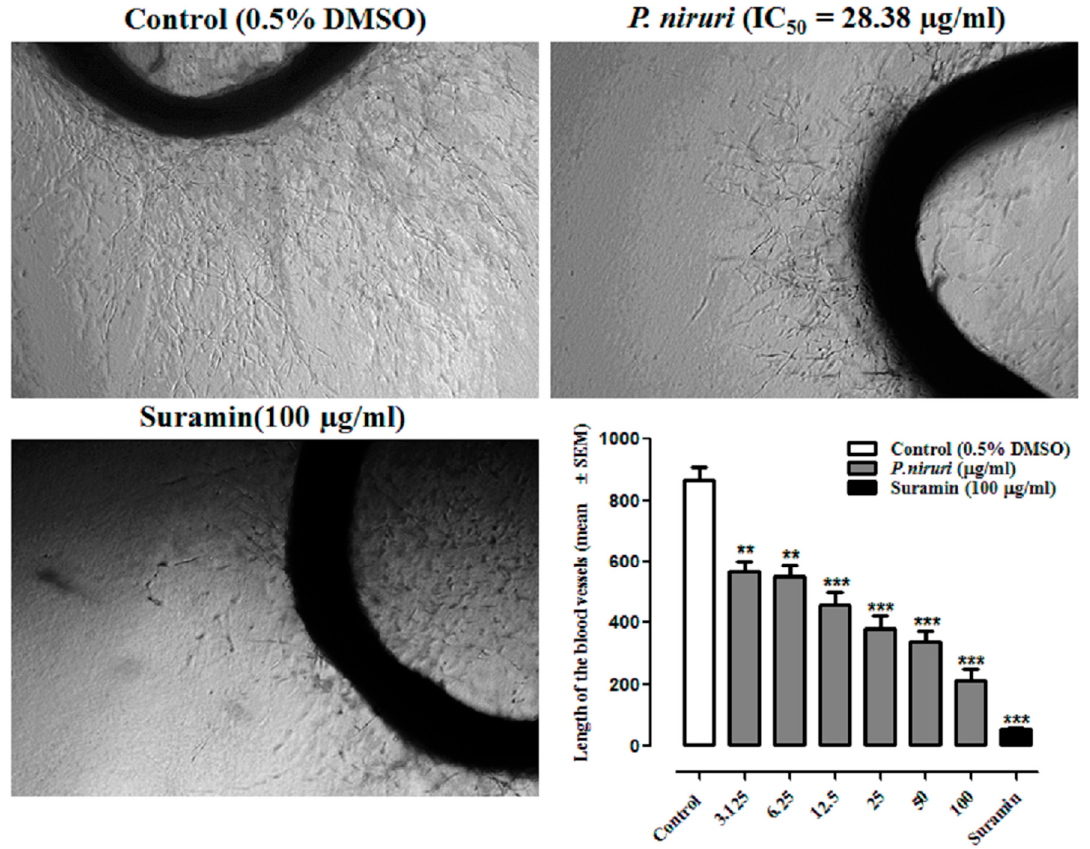
Figure 4. Photomicrographic represents the anti-neovascularization effects of P. niruri whole plant extract in rat aortic ring assay. Photos were taken at 4× magnification (scale bar 1000 µm). Where p ** < 0.01 and p *** < 0.001 vs. control Suramin; DMSCO: dimethyl sulfoxide.